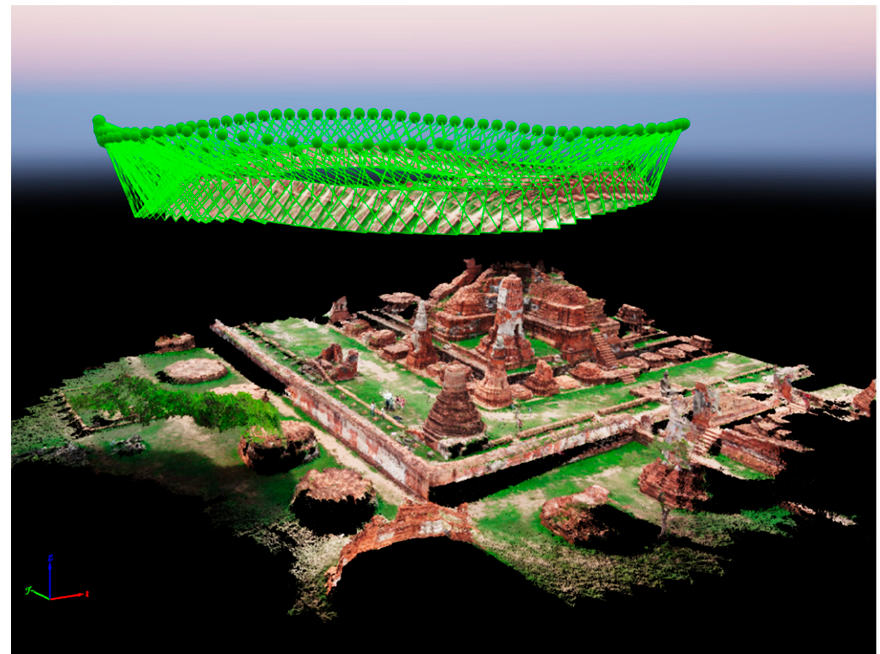
Figure 7. Camera position of the area of Wat Maha That, Ayutthaya flight.